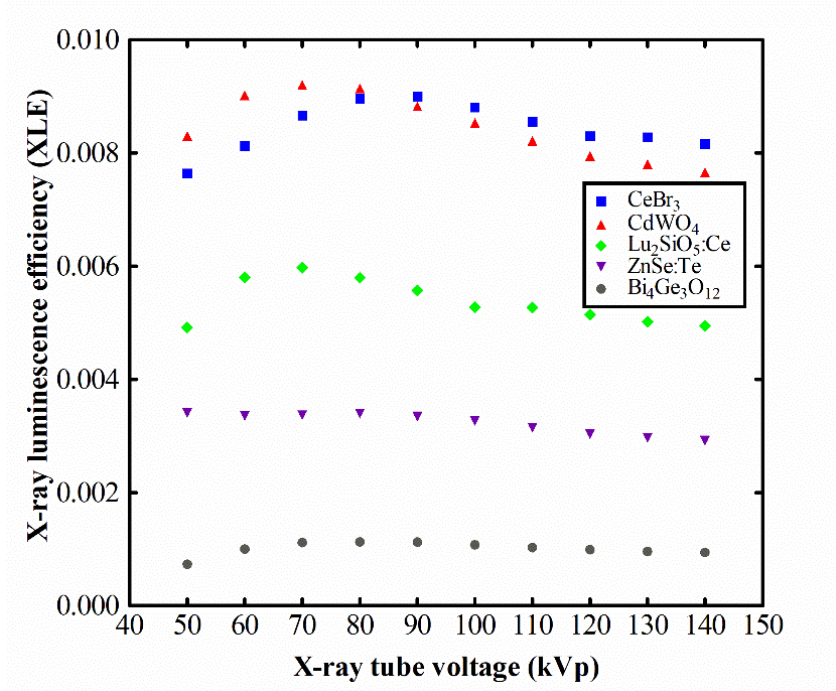
Figure 7. X-ray luminescence efficiency versus tube high voltage. CeBr 3 and CdWO 4 exhibit similar XLE responses, both starting from ~8 × 10 − 3 at 50 kVp, slightly culminating (~9 × 10 − 3 ) at 90 kVp and returning to ~8 × 10 − 3 at 140 kVp. Their attenuation coefficients (visible in Figure 8) present local peaks, namely the photoelectric absorption edges, at the energies of ~40 keV and ~69 keV, respectively. The other materials remain below 6 × 10 − 3 throughout the whole examined voltage range.